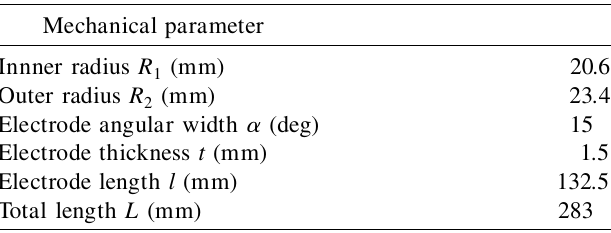
TABLE I. Mechanical design parameters of the BESM. Mechanical